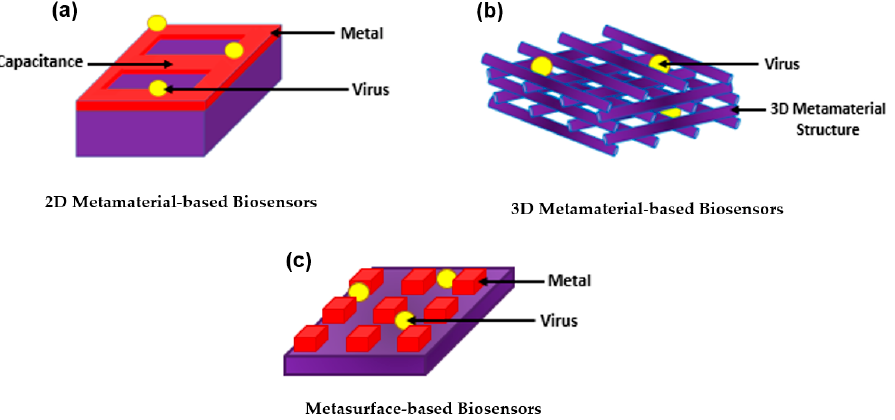
Figure 14. Common categories of metamaterials as ( a ) 2D metamaterial-based biosensors; ( b ) 3D metamaterial-based biosensors; and ( c ) metasurface-based biosensors.